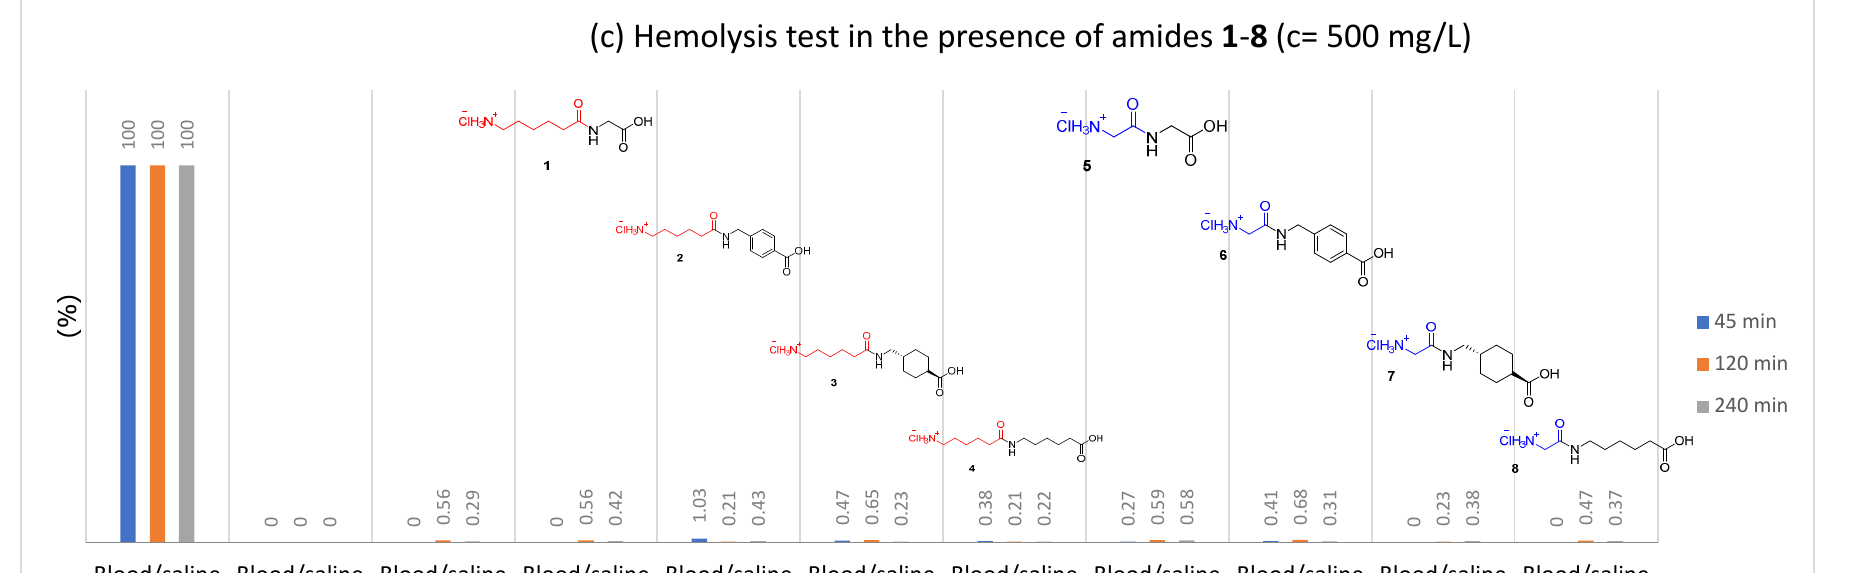
Figure 7. The influence of amides 1–8 on the stability of erythrocytes (hemolysis test); ( a ) c = 5 mg/L; ( b ) c = 50 mg/L; ( c ) c = 500 mg/L.